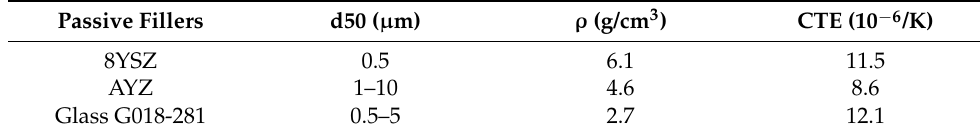
Table 2. Basic properties of filler